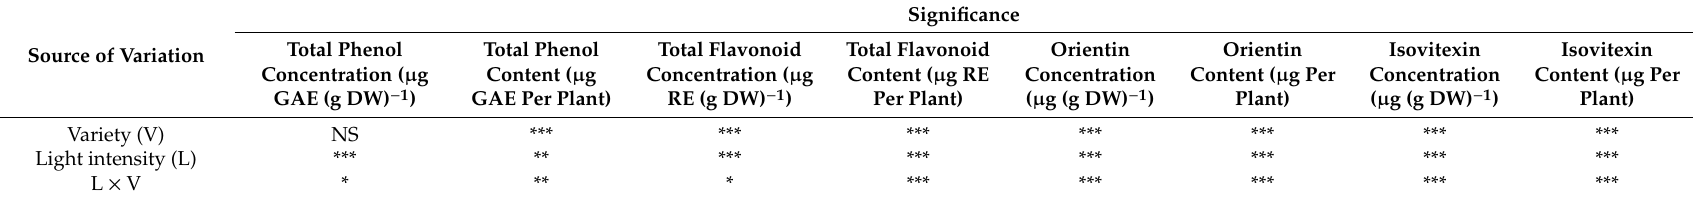
Table 2. ANOVA results of the main e ff ects of variety (V), light intensity (L), and their interaction e ff ect (L × V) on the secondary metabolites of Tainung No. 1 and Passiflora suberosa